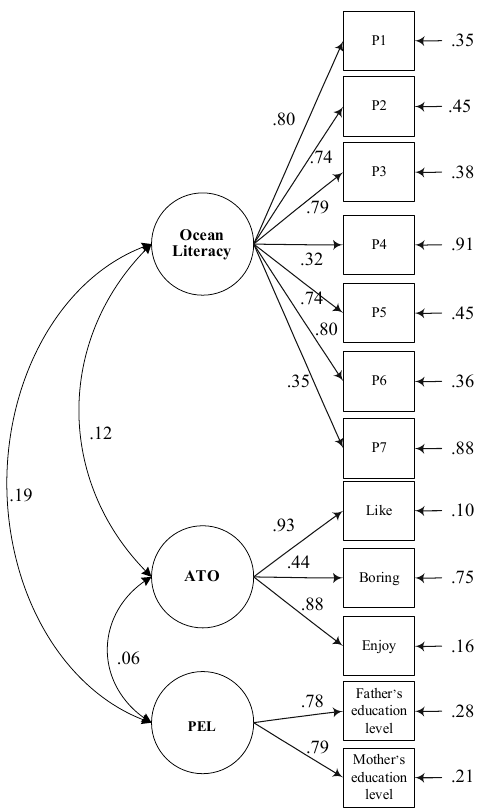
Figure 1. Measurement model of latent variables. Note: N = 945; PEL = parental educational level; ATO = attitude toward the ocean. All values are statically significant ( p < 0.001).